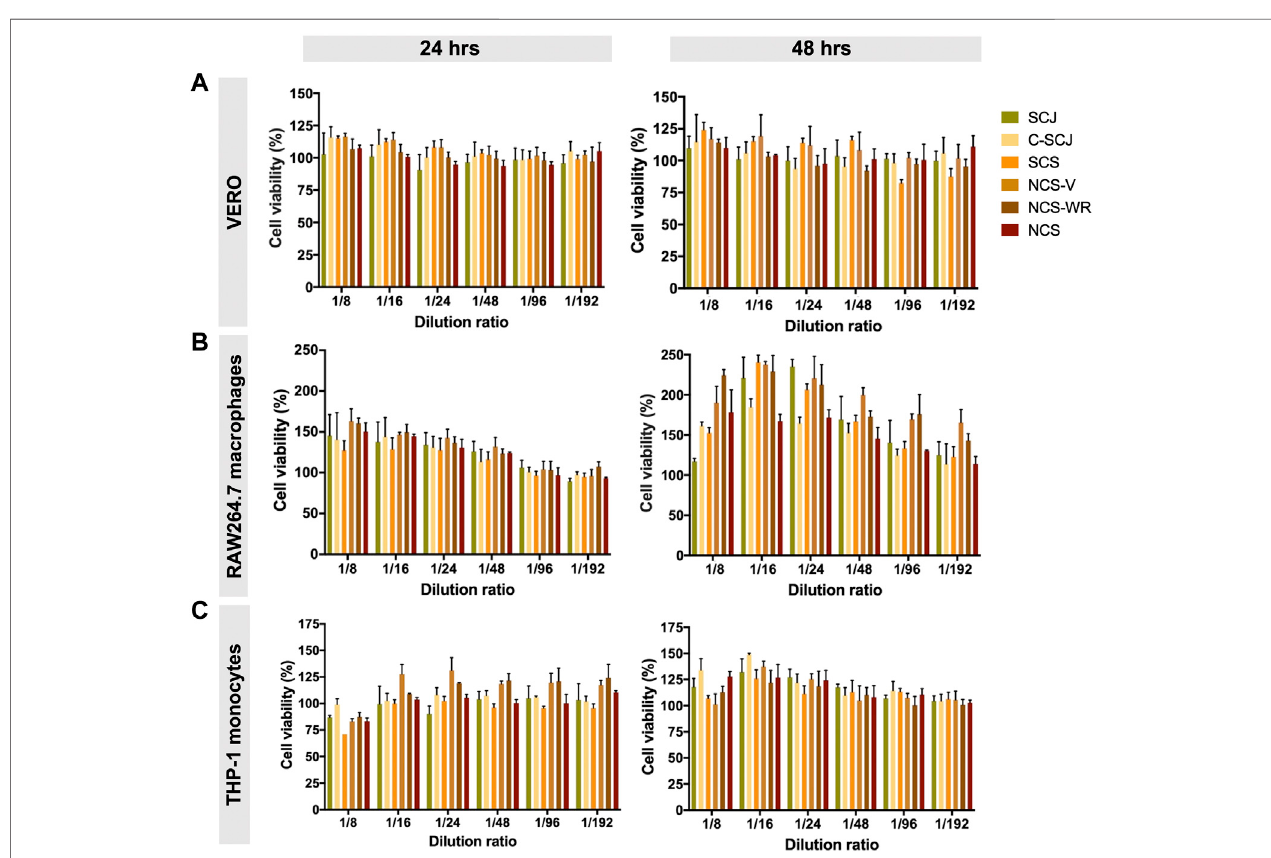
FIGURE3| Cellviabilityof (A) Verocells, (B) RAW264.7macrophagesand (C) THP-1monocytesuponexposuretosugarcane-derivedextractsfor24and48 h,as determinedbytheMTTassay.Extractdilutionswerepreparedfromstocksolutionscomprisingtheextractedfractionofa fi xedsampledryweightreconstitutedina fi xed volume. All extracts maintain or even enhance cell viability with respect to untreated controls. SCJ, Sugarcane juice; C-SCJ, clari fi ed sugarcane juice; SCS, sugarcane syrup;NCS,non-centrifugalsugarcane;NCS-WR,NCSproducedthroughwindowrefractanceevaporation;NCS-V,non-centrifugalsugarcaneproducedthrough vacuum-aided